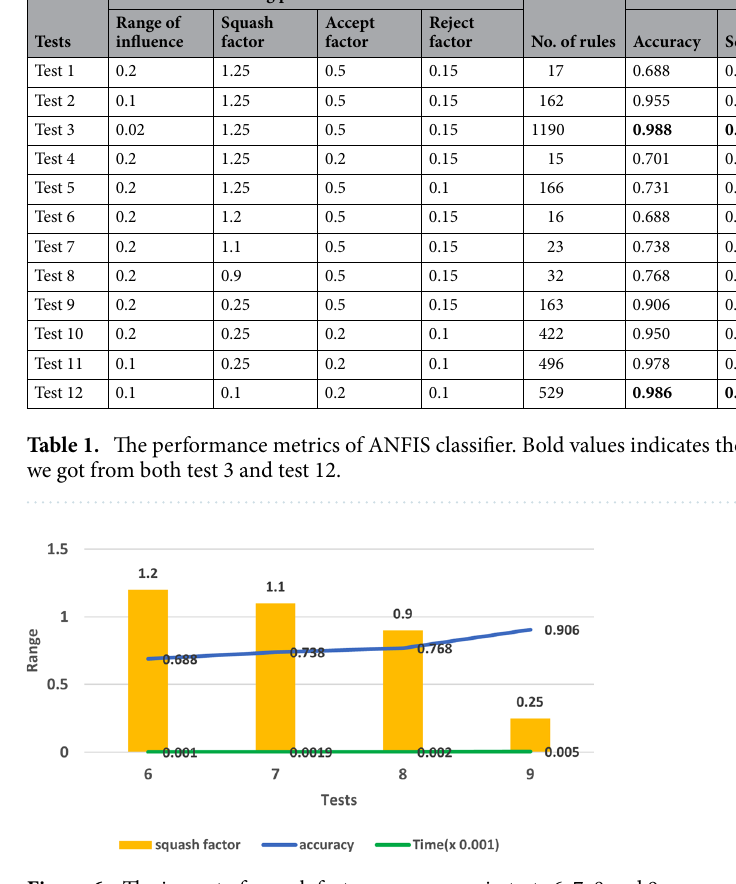
Figure 6. The impact of squash factor on accuracy in tests 6, 7, 8 and